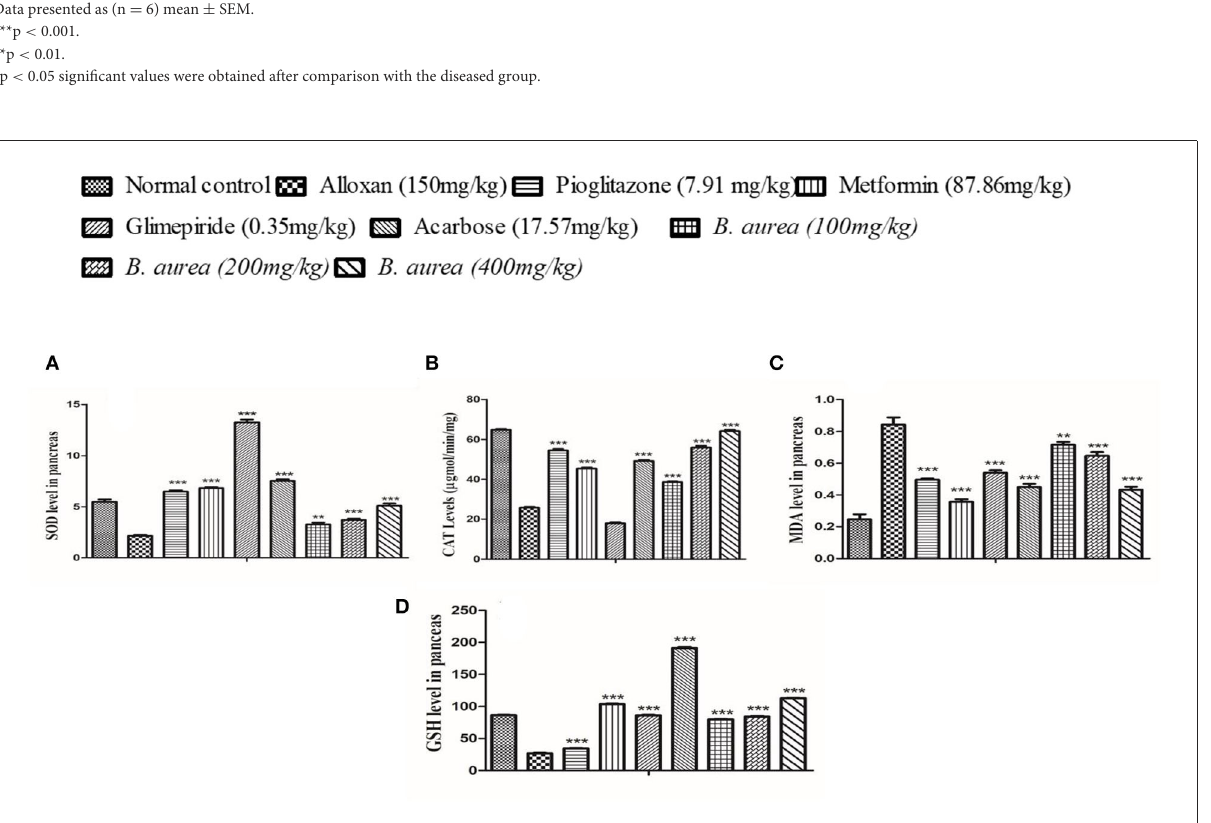
FIGURE5 Effect of B. aurea on antioxidant enzyme levels in the pancreas of diabetic animals. (A) superoxide dismutase (SOD), (B) catalase (CAT), (C) melanoaldehyde (MDA), and (D) reduced glutathione (GSH). *** p < 0.001, ** p < 0.01, * p < 0.05 significant